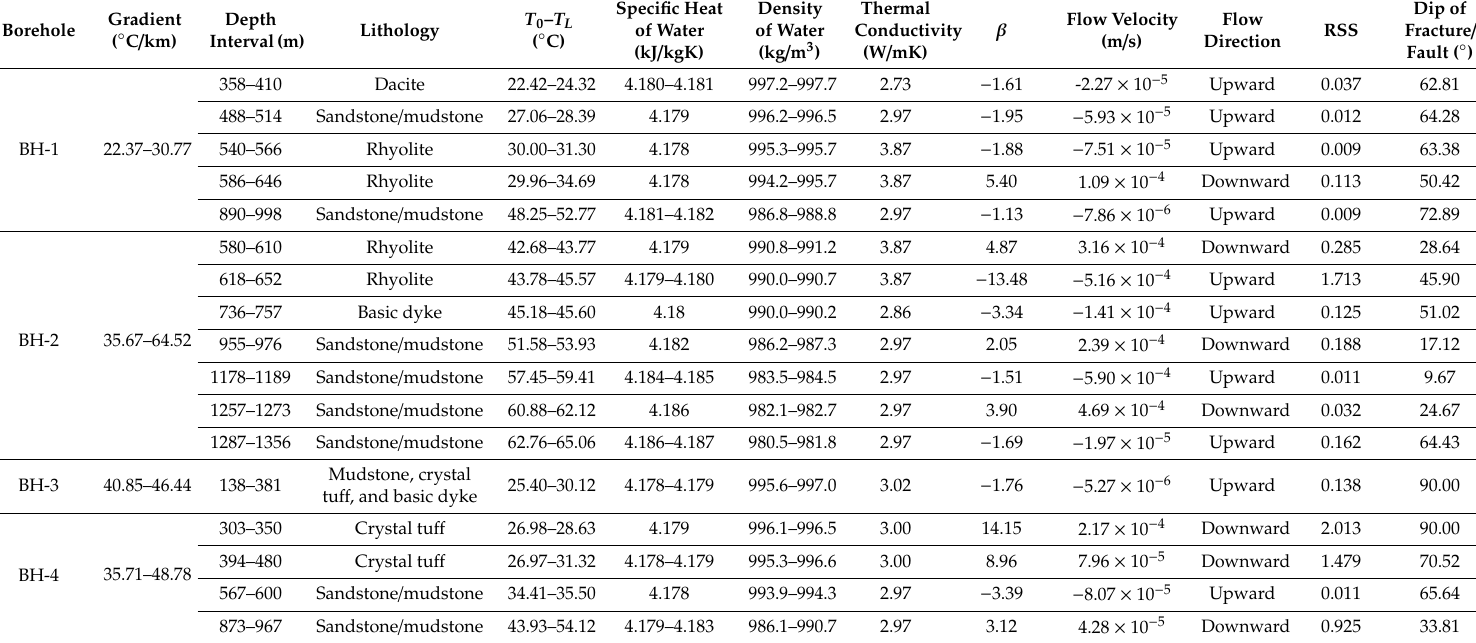
Table 1. Estimated vertical velocity, dip of fracture / fault, and thermal properties in the boreholes. Negative and positive signs of flow velocity indicate upward and downward flows,